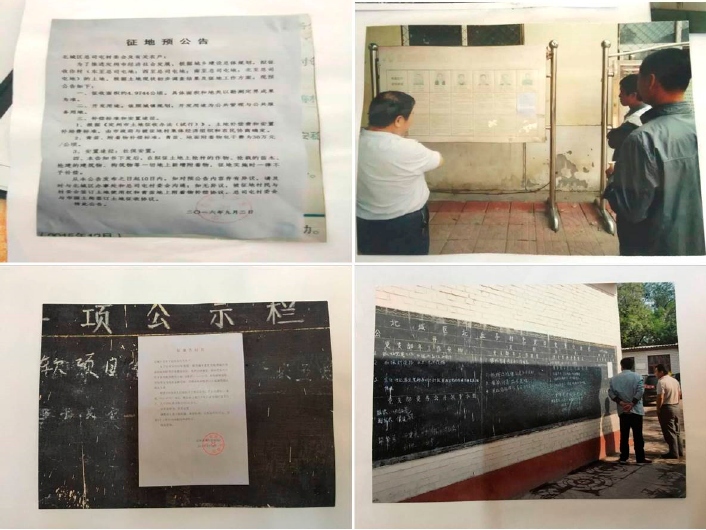
Figure 3. The announcement of land expropriation in the column of Zongsitun Village.